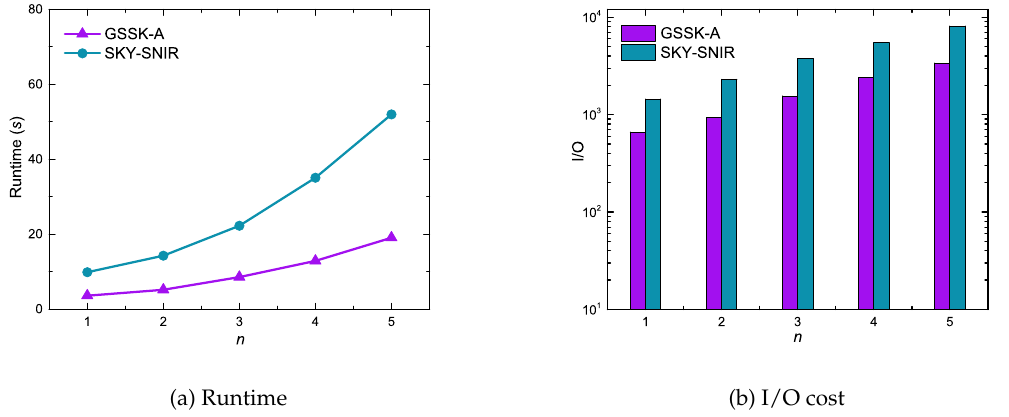
Figure 12. Effect of the number of keywords on runtime and I/O